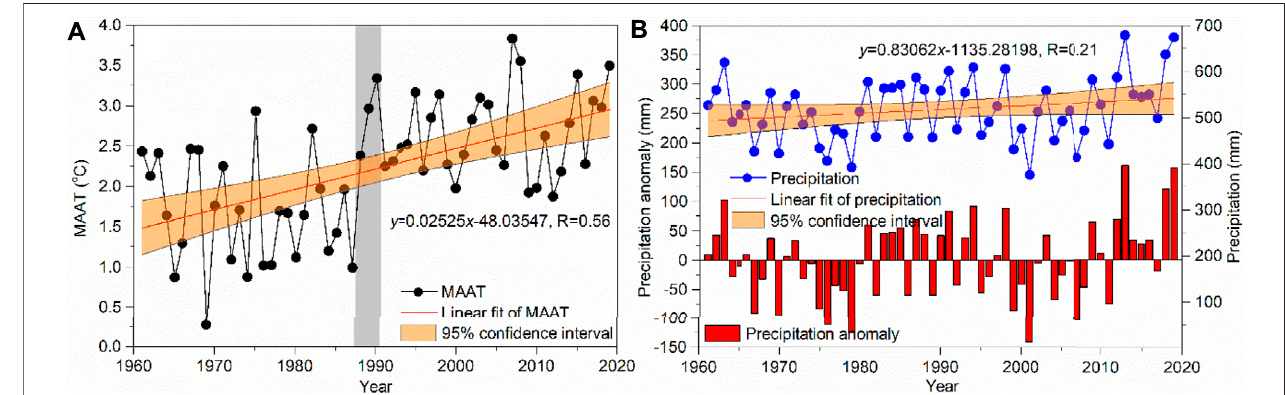
FIGURE 2 | Changes in the mean annual air temperature (MAAT) and mean annual precipitation during 1961 – 2019 in Heilongjiang Province, Northeast China during 1961 – 2019.